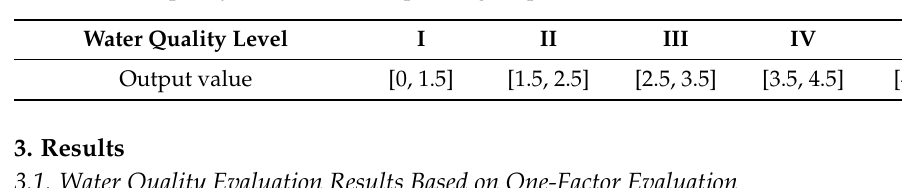
Table 1. Water quality levels and corresponding output values.